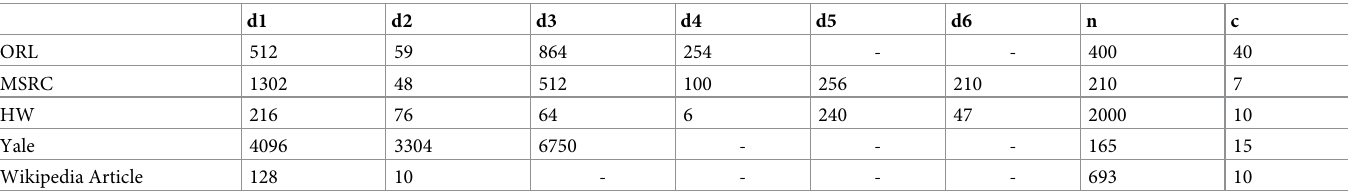
Table 1. The specific details of the five datasets ORL, MSRC, HW, Yale, Wikipedia